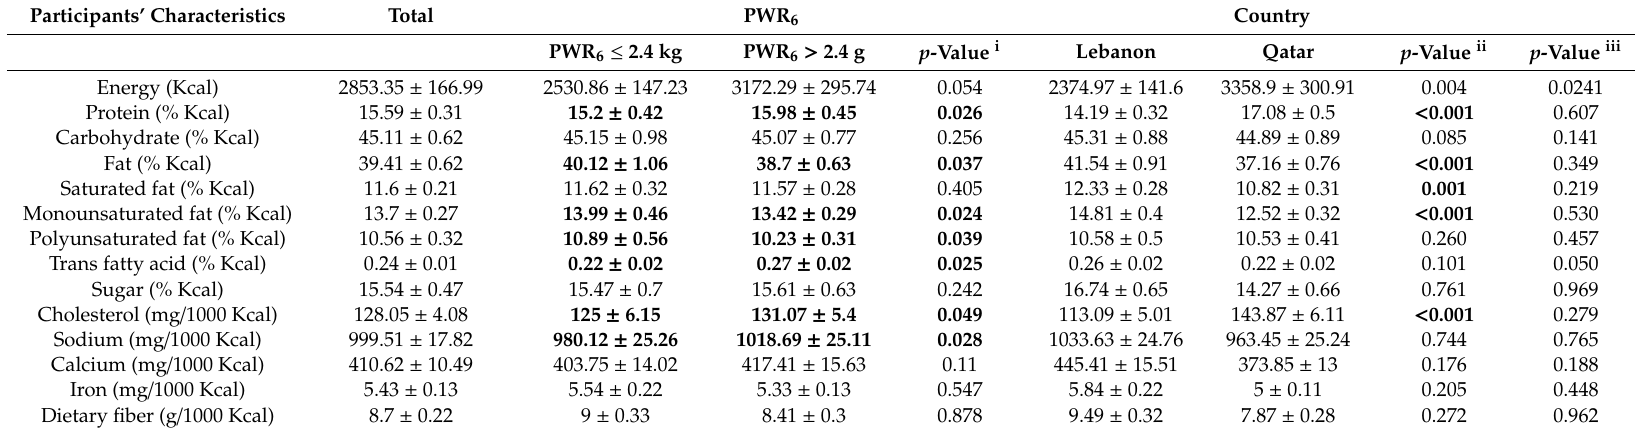
Table 3. Energy-adjusted macro- and micronutrient intakes of study participants stratified by PWR 6 (below and above median values) and country (Lebanon and